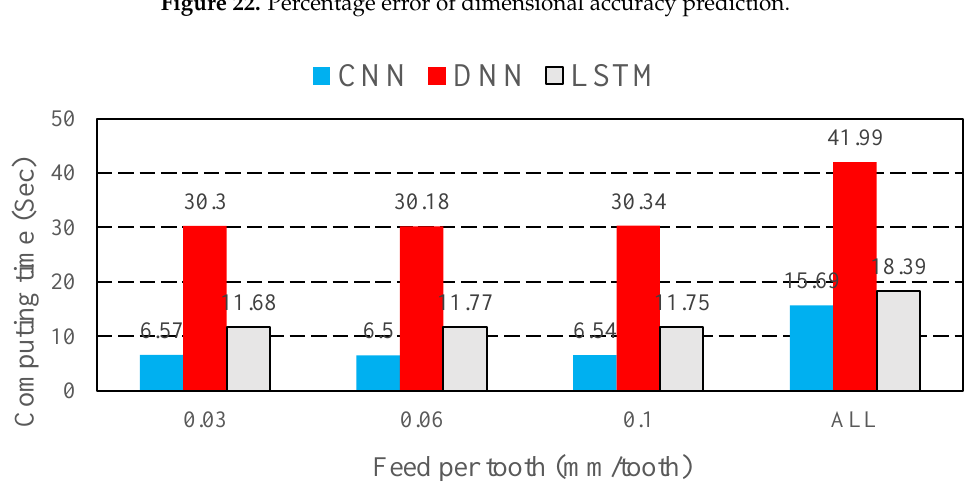
Figure 22 . Percentage error of dimensional accuracy prediction. Figure 22. Percentage error of dimensional accuracy prediction.